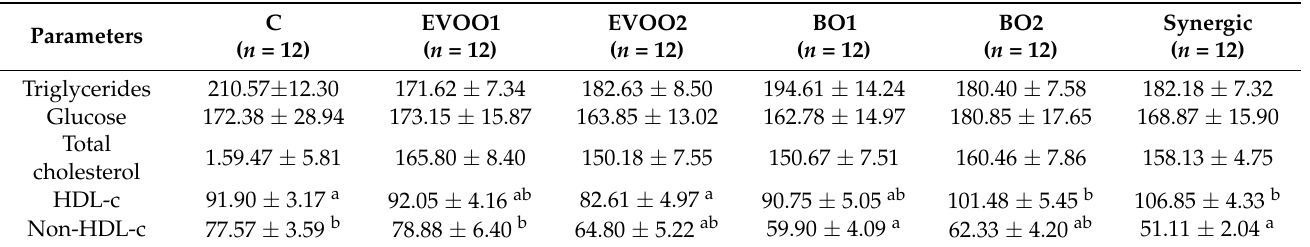
Table 8. Biochemical parameters (mg.dL − 1 ) of the animals after 90 days of